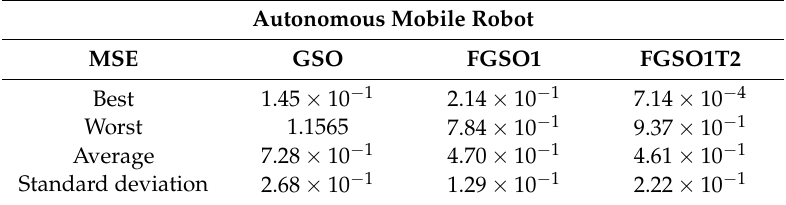
Table 3. Results with noise for